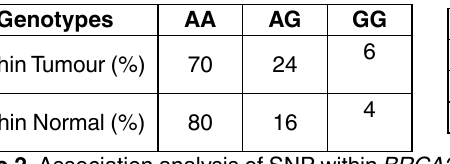
table 3. Proportion of different genotype within CMT affected and normal animals